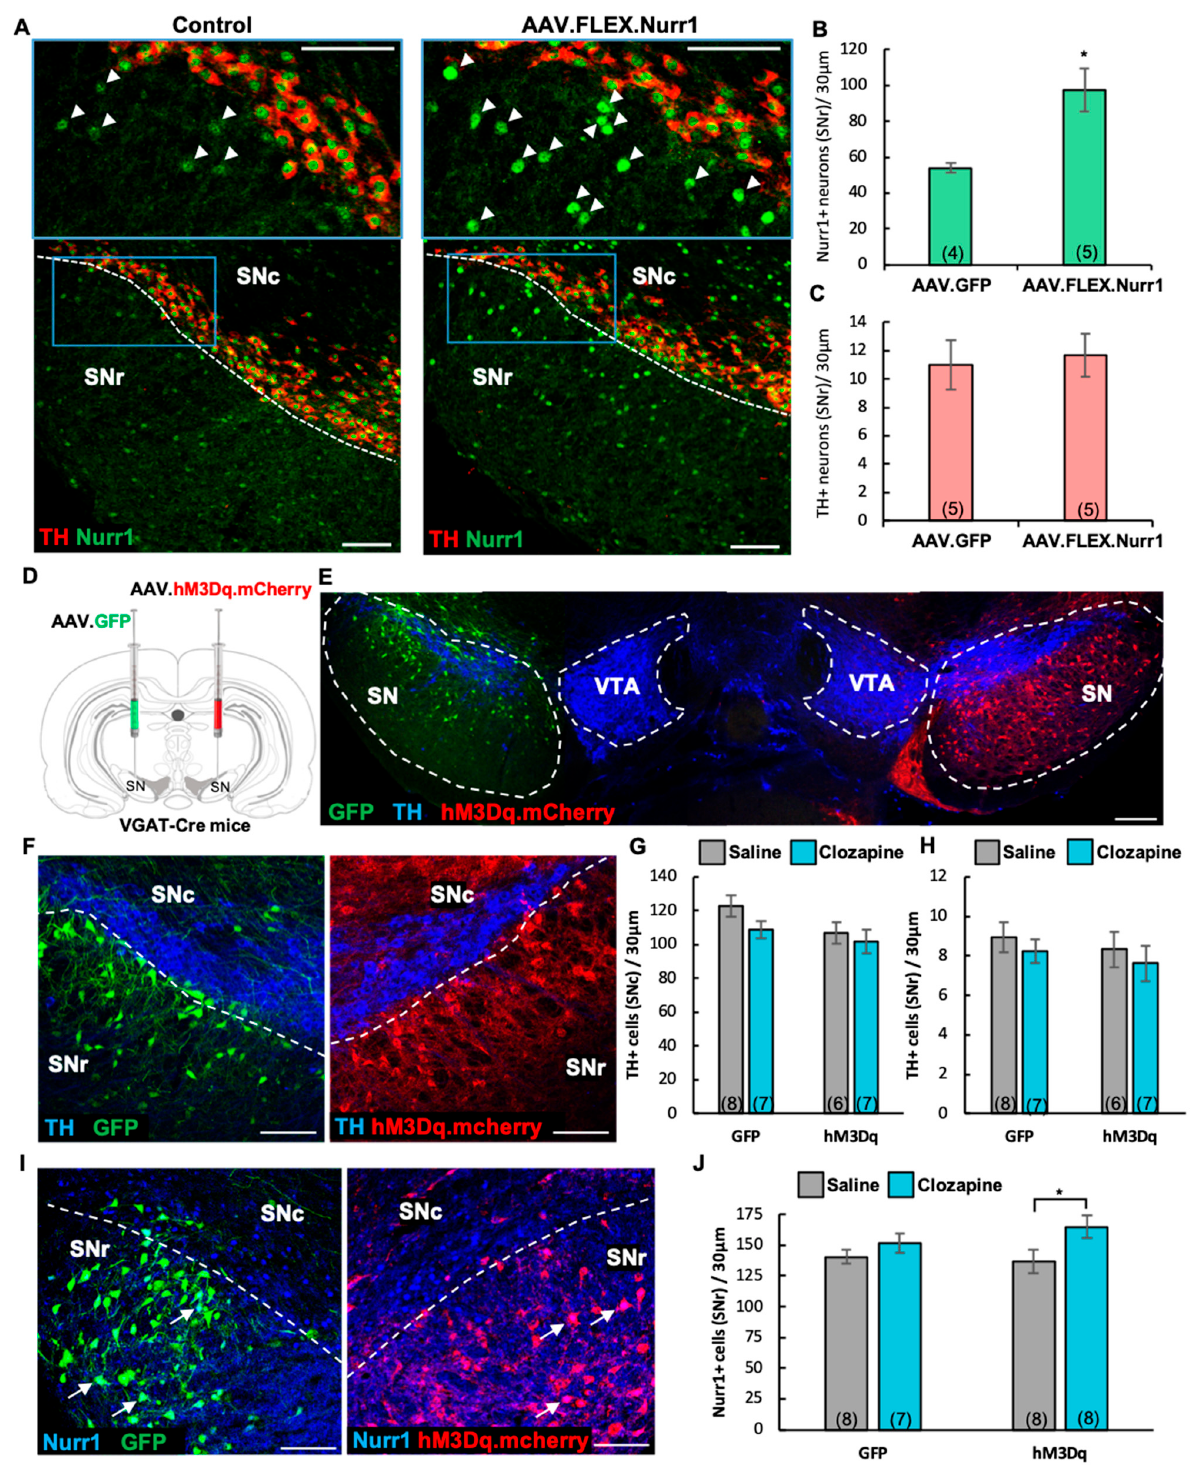
Figure 8. Selective Nurr1 overexpression does not elicit a TH phenotype while chronic activation of GABAergic cells is sufficient to induce Nurr1. ( A ) Confocal images of representative SN sections indicating enhanced Nurr1 immunoreactivity (arrowheads) shown at higher magnification (insets, blue box) on the side of the brain injected with Cre-dependent AAV Nurr1 miRNA (AAV.FLEX.Nurr1), when compared to the contralateral uninjected side (control). Scale bars = 200 µ m. ( B , C ) Quantification of IHC preparations shown in A indicates that AAV.FLEX.Nurr1 injection increased the number of Nurr1+ cells in the SNr (( B ), t (7) = 2.96, p < 0.05) but was not sufficient to